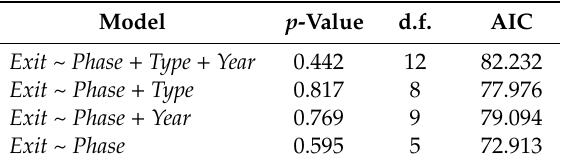
Figure 2. Number of successes (1) and failures (0) in each phase (1 = “nesting”; 2 = “courtship”; 3 = “fixation”; 4 = “incubation”; 5 = “hatching”; 6 = “survival”). Table 3. Results of the performed GLM analysis, with the factors considered for each model, its p -value (from a Chi square test), its freedom degrees and its AIC value. p -value d.f.